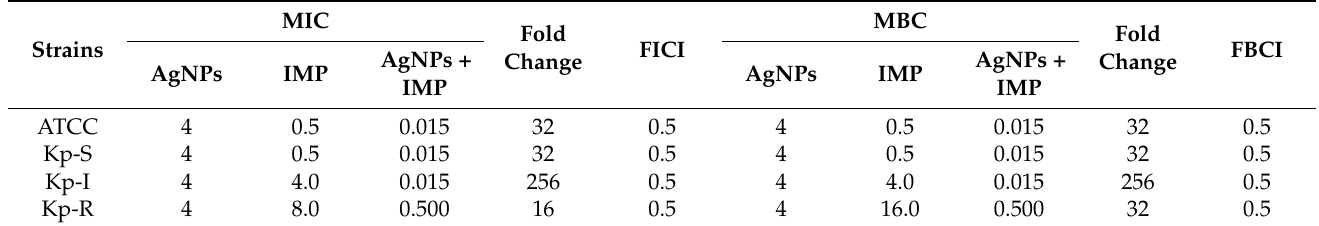
Table 1. Minimal inhibitory concentration and minimal bactericidal concentration assay data of silver nanoparticles, Imipenem, and their association against different profiles of K. pneumoniae